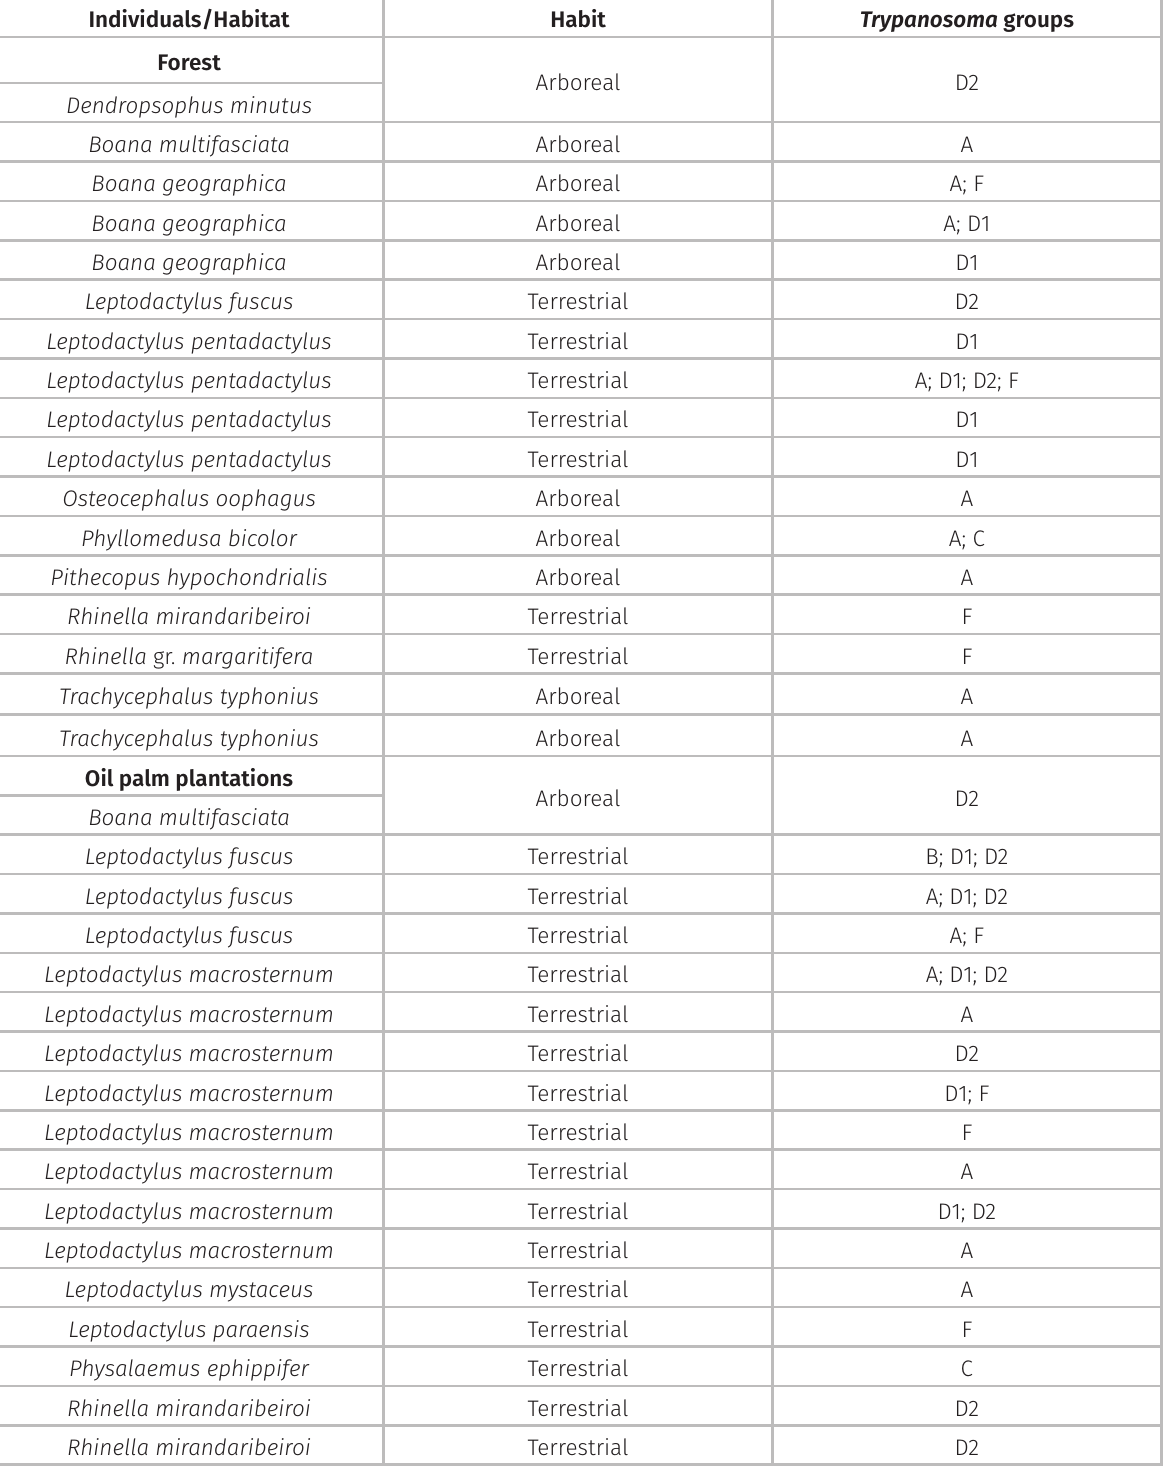
Table II. Parasites of the genus Trypanosoma in anurans from forest areas and oil palm plantations in the municipality of Tailândia, Pará,